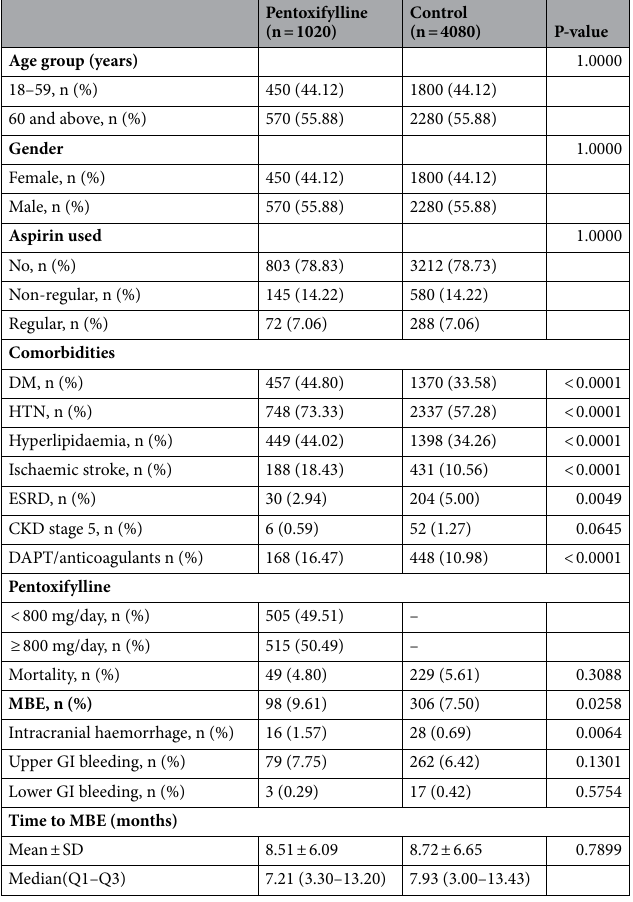
Table 1. Demographic information of patients with chronic kidney disease. CKD, chronic kidney disease; DAPT, dual antiplatelet therapy; DM, diabetes mellitus; ESRD, end-stage renal disease; GI, gastrointestinal; HTN, hypertension; MBE, major bleeding event; SD, standard deviation.